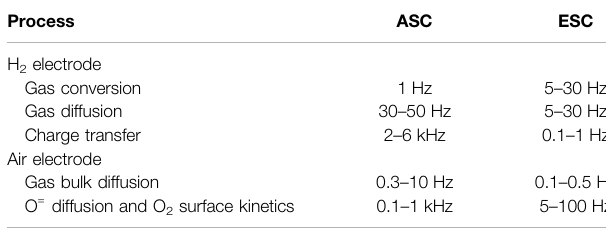
TABLE 3 | Summary of different electrode processes occurring in both con fi gurations evaluated through DRT gas shift analysis and available